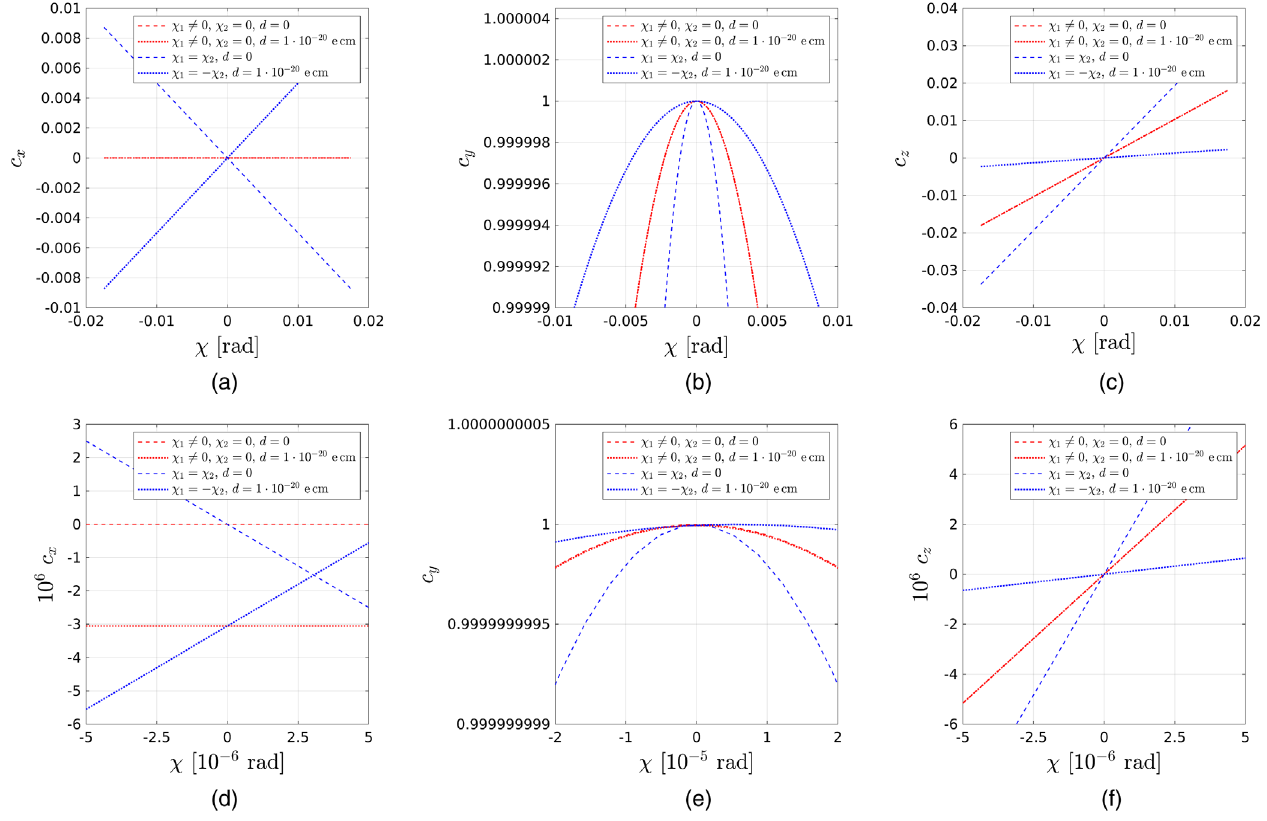
Þ at the rf Wien filter for different combinations of spin rotations in the ; c ; c x y z